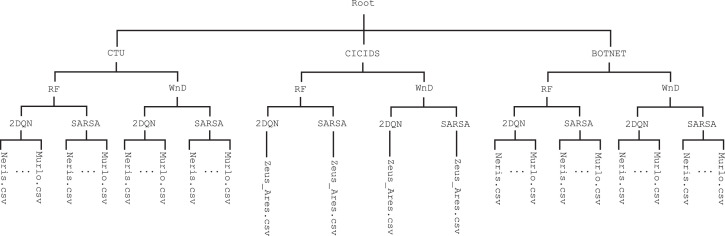
Dataset structure.